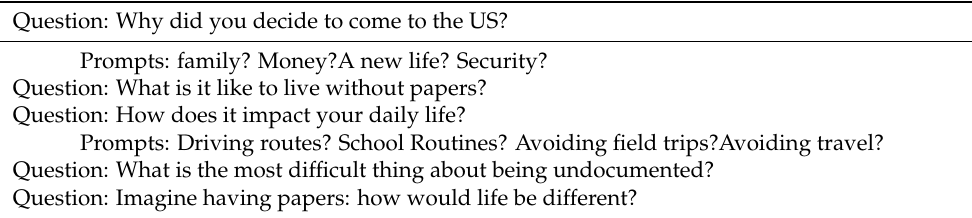
Table 2. Questions and prompts for the topic Undocumented